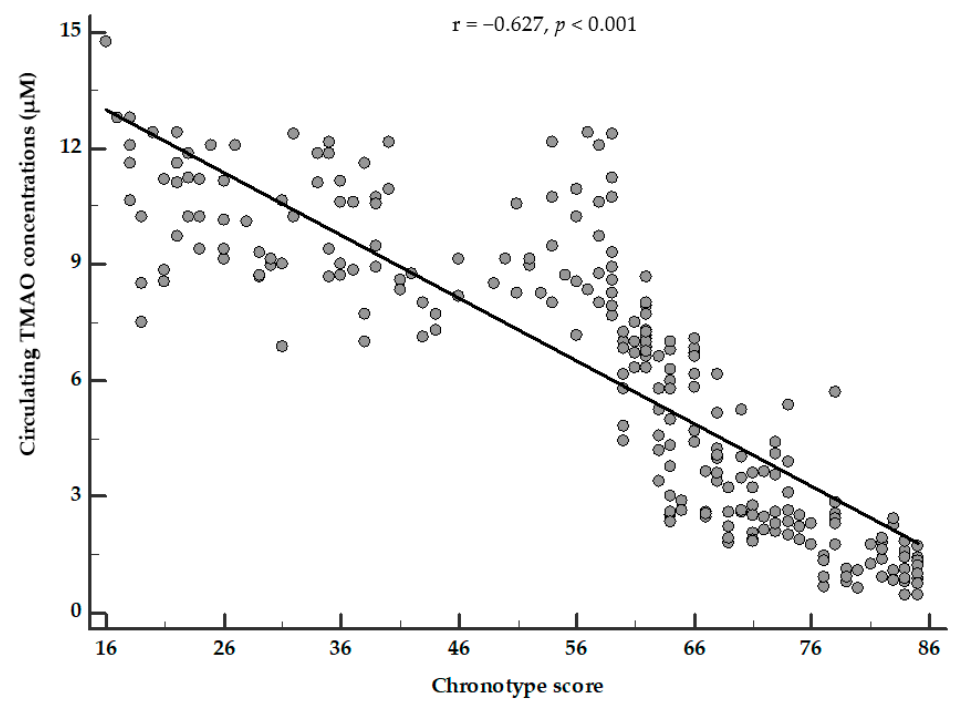
Figure 2. Partial correlation between circulating TMAO concentrations and chronotype score. Circulating TMAO concen ‐ trations were negatively associated with the chronotype score, after adjusting for BMI and MEDAS ‐ derived MD score. Correlations between variables were performed using Pearson r correlation coefficients. A p value in bold type denotes a significant difference ( p < 0.05). TMAO, trimethylamine N ‐ oxide.